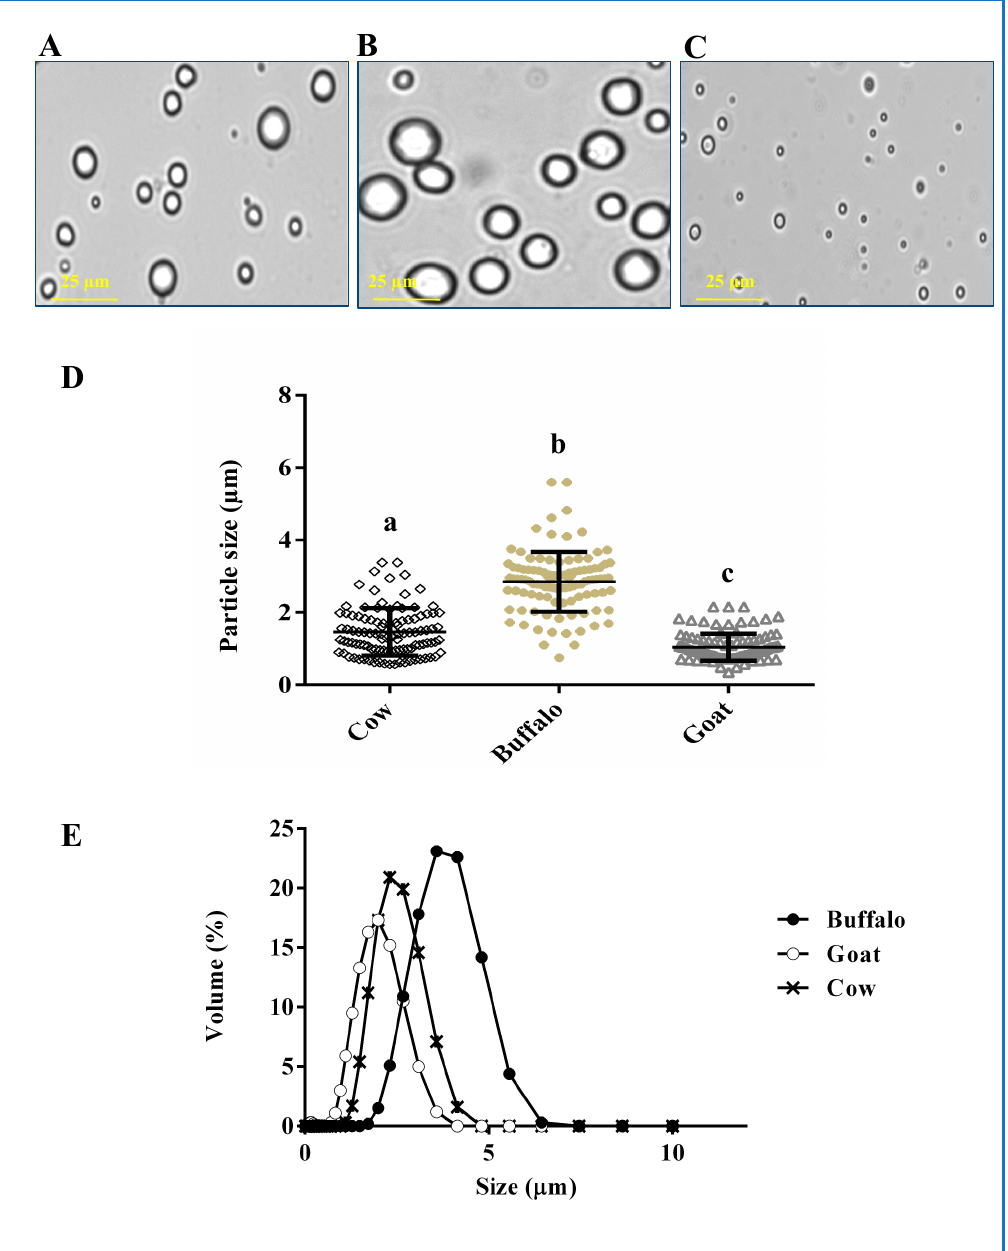
Figure 4. Milk fat globule shape and size distribution in ( A ) cow, ( B ) water buffalo, and ( C ) goat determined with differential interferential contrast; ( D ) Comparative analysis of size variation in milk fat globules calculated using differential interferential contrast images across the animals; ( E ) Fat globule size distribution based on dynamic light scattering. Representative data of three inde- pendent biological samples performed in triplicate. Different letters indicate a significant difference ( p ≤ 0.001). Scale bar = 25 µ